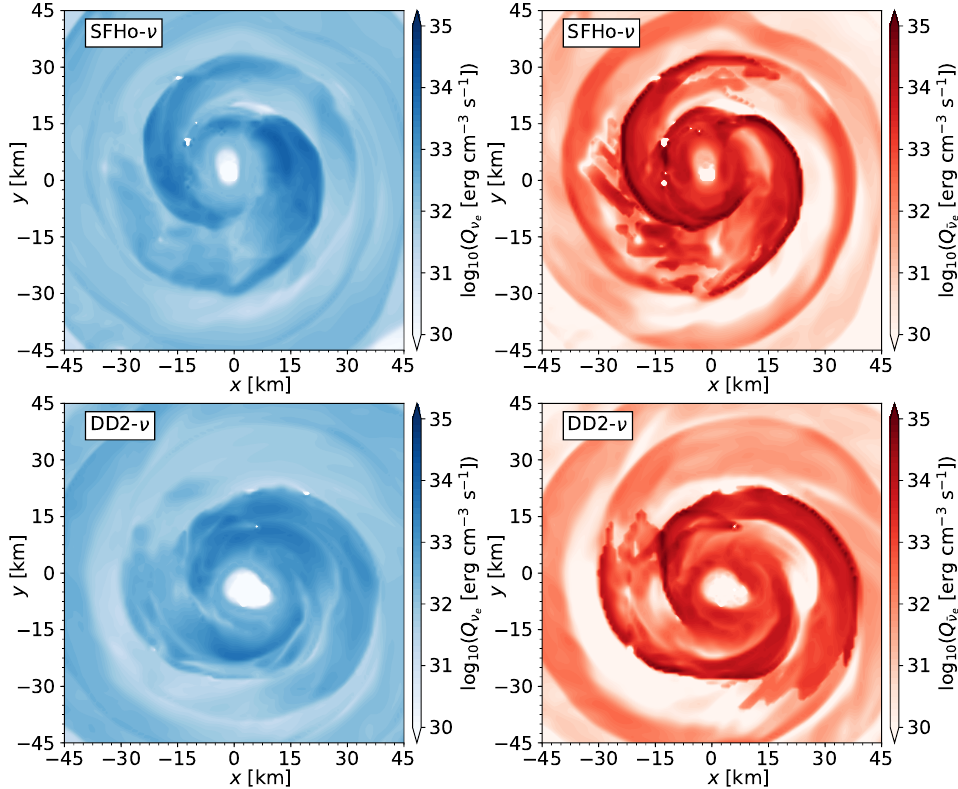
Figure 9. Effective emissivities 10 ms after the merger in the x - y plane of electron neutrinos ( left panels) and electron antineutrinos ( right panels) for the SFHo- ν ( upper panels) and DD2- ν ( lower panels) runs. Here, we notice that the emissions are small at the densest portion of the core, concentrate at the hot parts of the disk/spiral arms, and decrease towards the outer regions of the